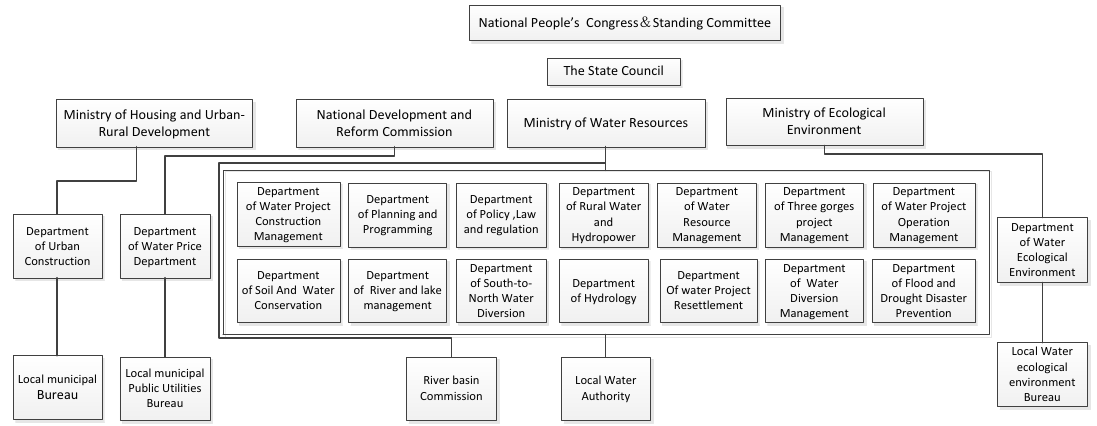
Figure 2. China’s water management framework.